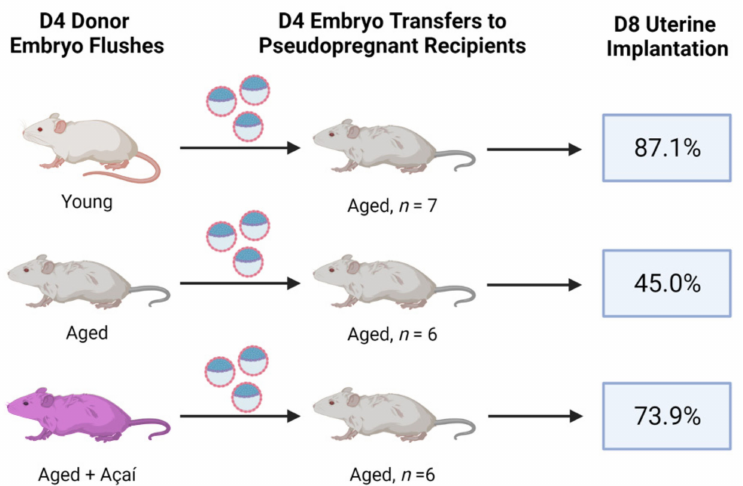
Figure 2. Embryo transfer outcomes in aged recipient mice. Embryos were collected from super- ovulated, bred mice on gestational day 4 (D4) and transferred into pseudopregnant D4 mice. The implantation rates were determined on D8.